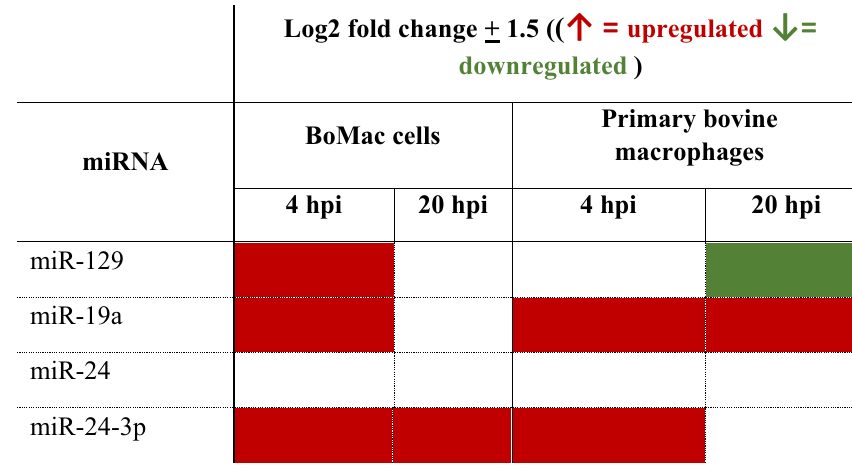
Table 3. miRNA expression in MAP infected bovine macrophages. Red boxes indicate upregulated miRNA and green boxes represent downregulated miRNA compared to control uninfected cells. While boxes indicate no significant differential expression. Log2 fold changes ± 1.5 compared to control uninfected cells was considered differentially regulated.